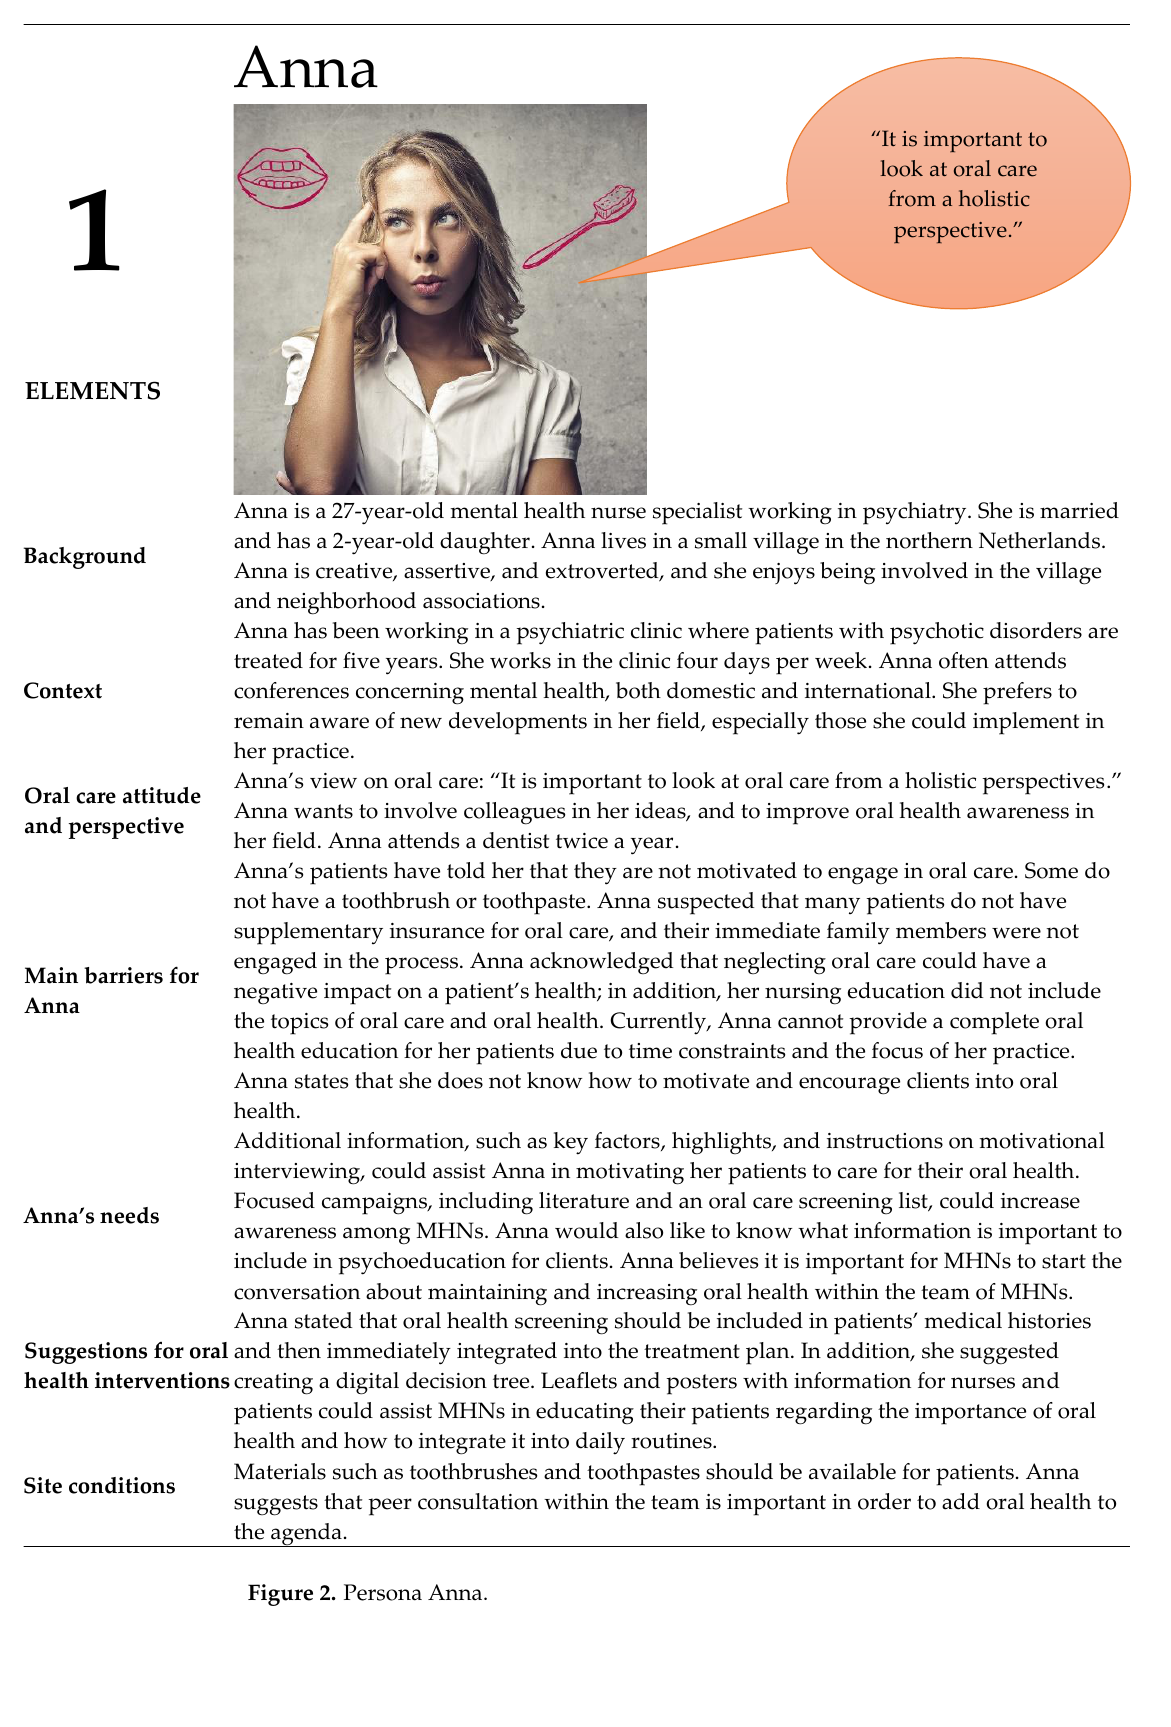
Figure 2. Persona Anna.